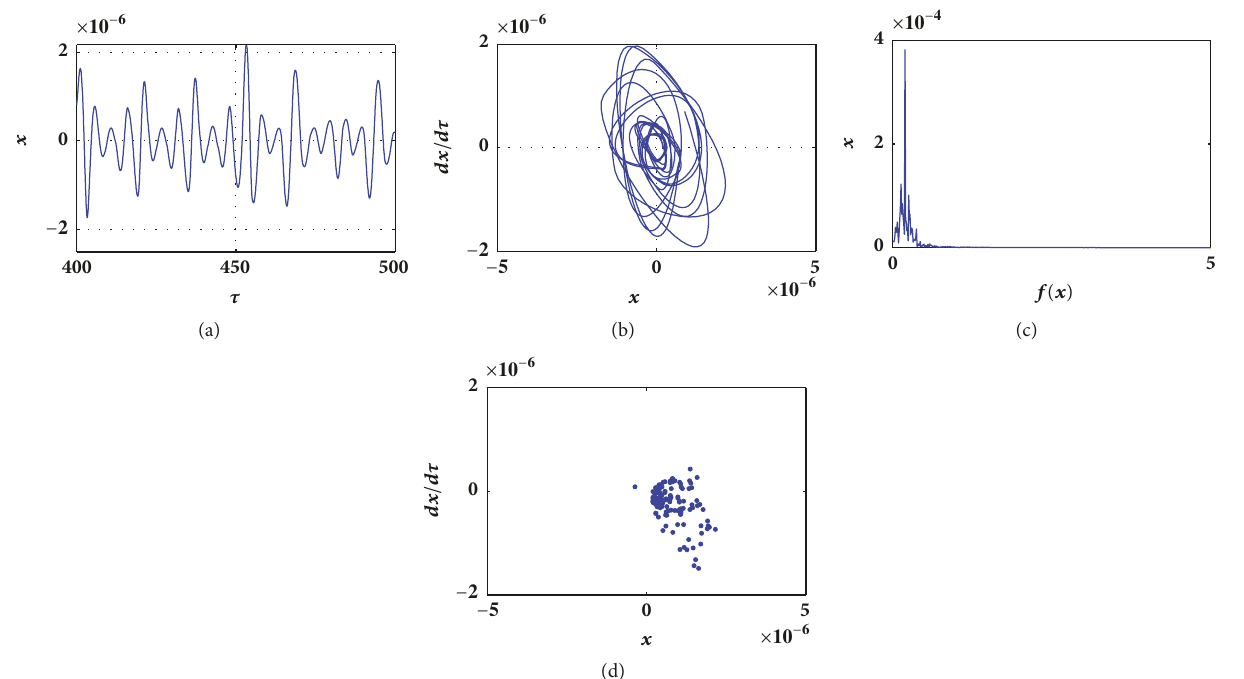
Figure 7: The time history, the phase diagram, spectrum, and the Poincar´e section of the system (6) for 𝜀 = 0.655 , 𝑄 = 1 .